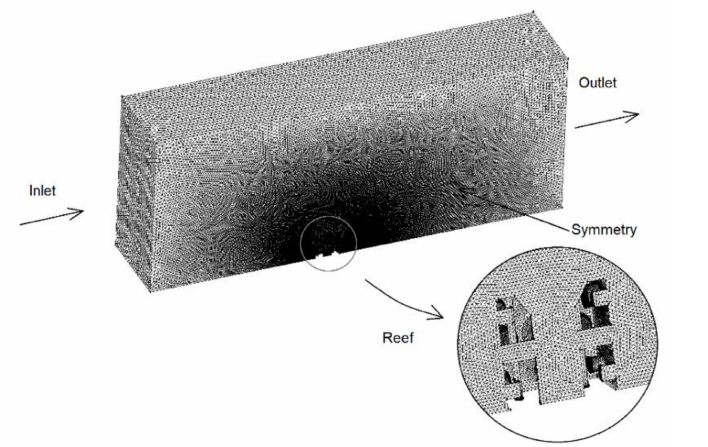
Figure 7. Computational mesh.